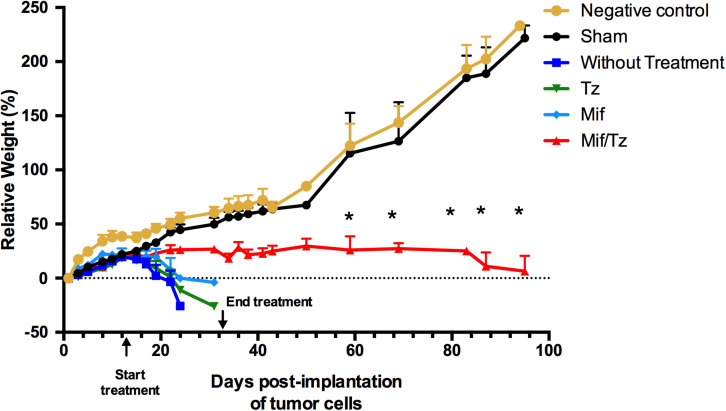
Tumor growth in the orthotopic rat model of glioma was evaluated by comparing animals weight between groups: negative control () and sham surgery (); and in four groups with implanted glioma cancer cells, one without drug treatment () and the other given temozolomide only (Tz) (), mifepristone only (Mif) (), and mifepristone/temozolomide (Mif/Tz) (). Each point of the graphic represents the mean ± SEM of six animals. *Significant difference (p < 0.05) between Mif/Tz and sham.